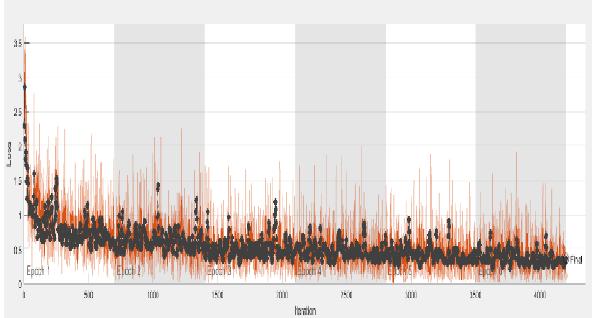
Figure 6. Accuracy plot at each iteration of VGGNet training.